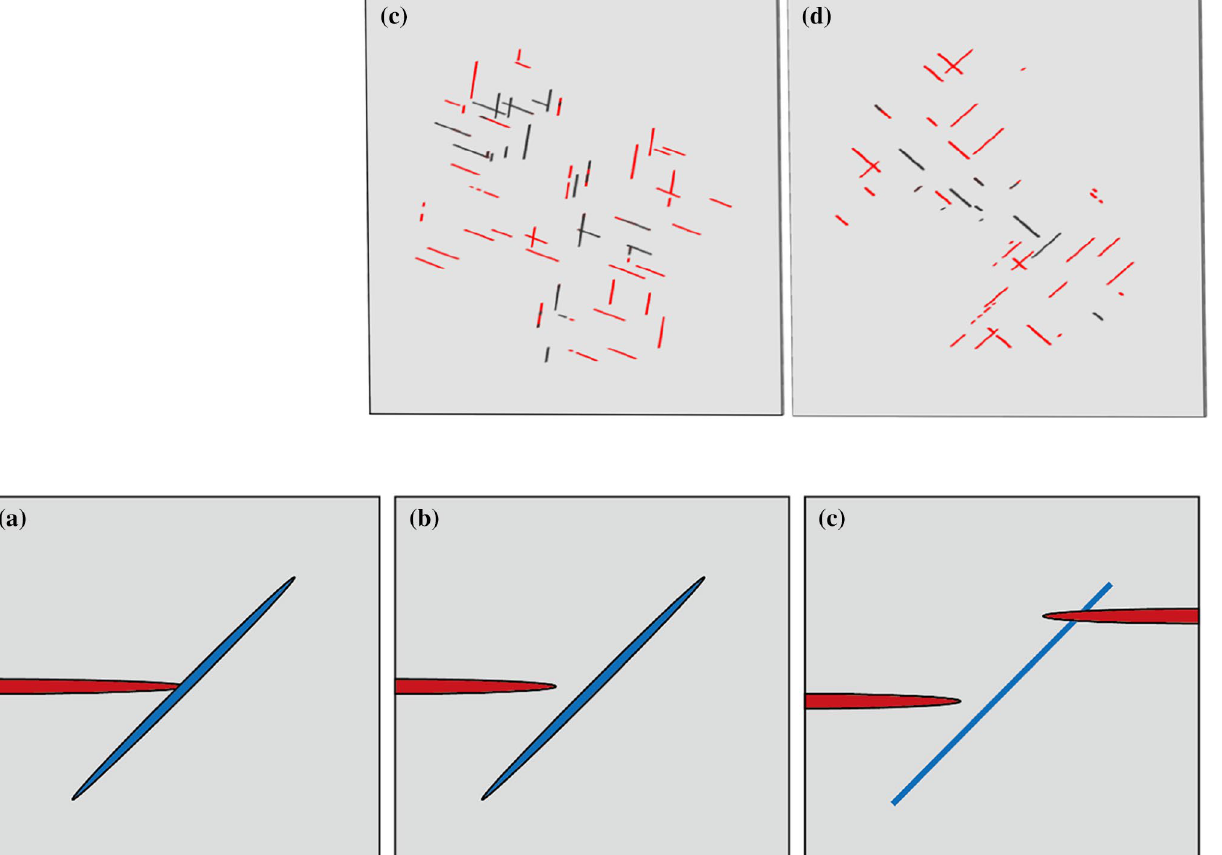
opened but not connected with artificial fractures and self-supported fractures formed (blue); Subfigure ( c ) means natural fractures not opened ignore whether connected with artificial